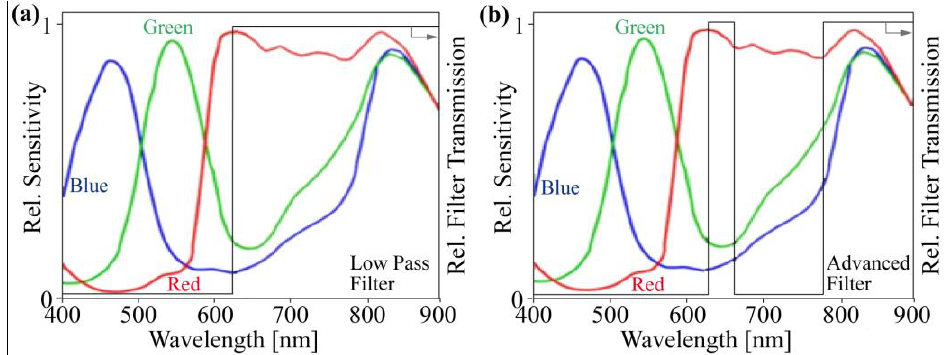
Figure 5. ( a ) Enabling the RGB CMOS chip for red and NIR sensitivity through ideal low-pass ( b ) or ideal double band pass